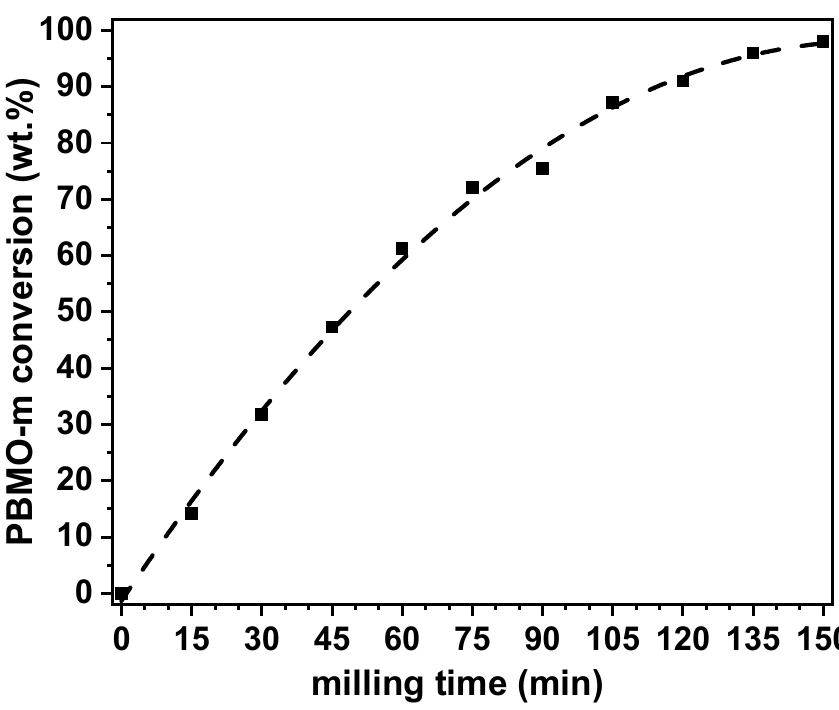
Figure 2. Quantification by Rietveld refinement of the XRD patterns in Figure 1 of the new perovskite phase formed when the Pr 6 O 11 /BaO 2 /MnO powder mixture is subjected at increasing milling time.